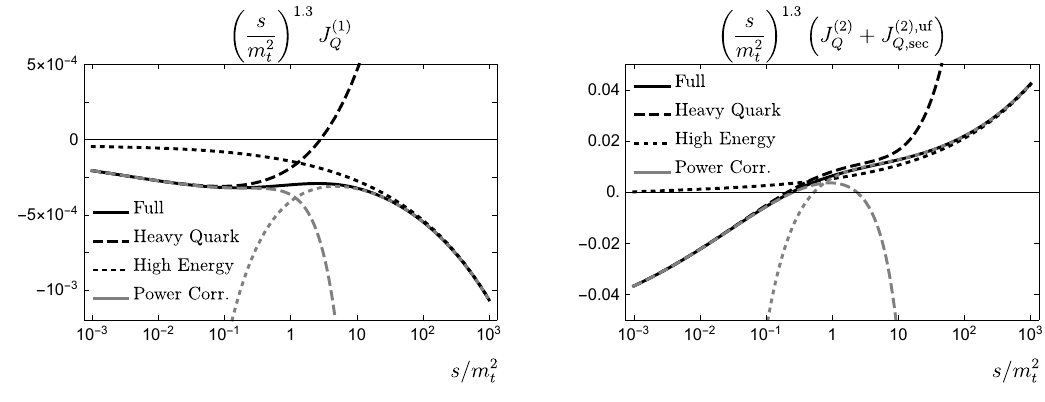
Figure 8 . Left: O ( (cid:11) s ) coe(cid:14)cient of the SCET massive primary quark jet function (black solid) in comparison to the leading power results of the massless (black dotted) and bHQET (black dashed) limit. Also shown are the curves including the respective next terms in the small mass and bHQET expansions (gray dotted and dashed, respectively). Right: Analogous plot for the O ( (cid:11) 2 of the universal SCET massive primary quark jet